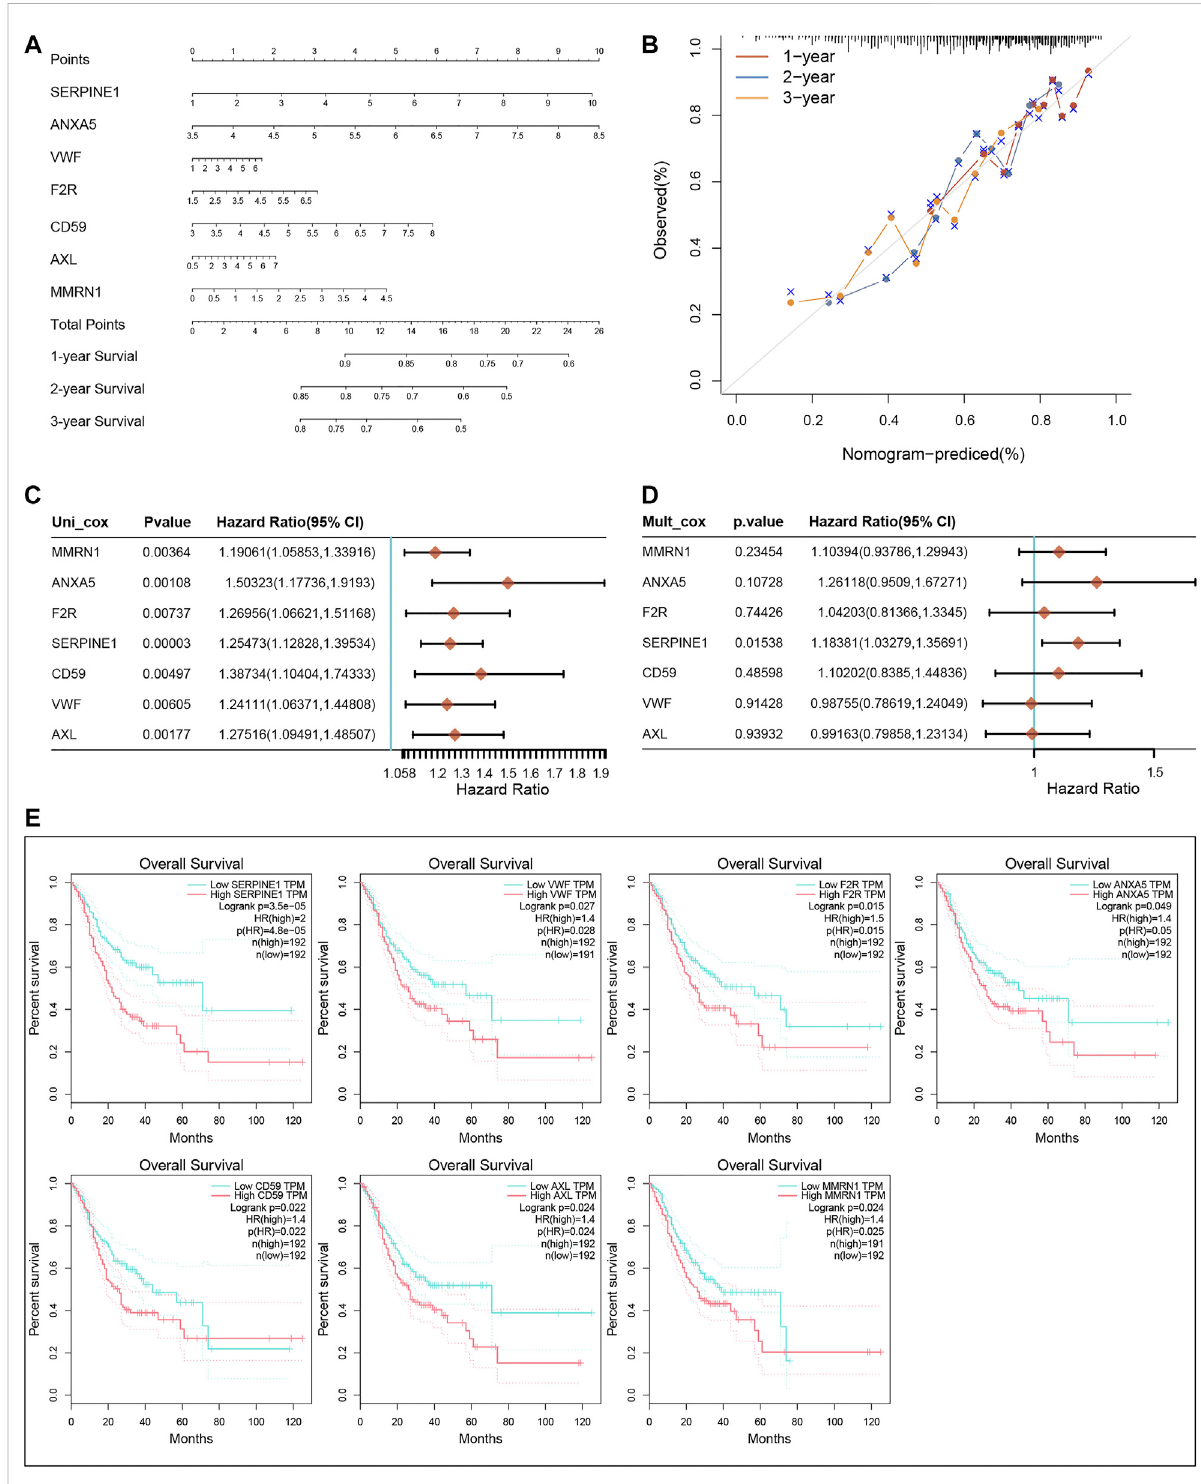
FIGURE 5 Nomogram of the Coag-Score model. (A,B) The nomogram and calibration curve of the Coag-Score model. (C,D) Univariate and multivariate Cox regression analyses for a single gene in the Coag-Score. (E) KM survival curves of a single gene in the Coag-Score